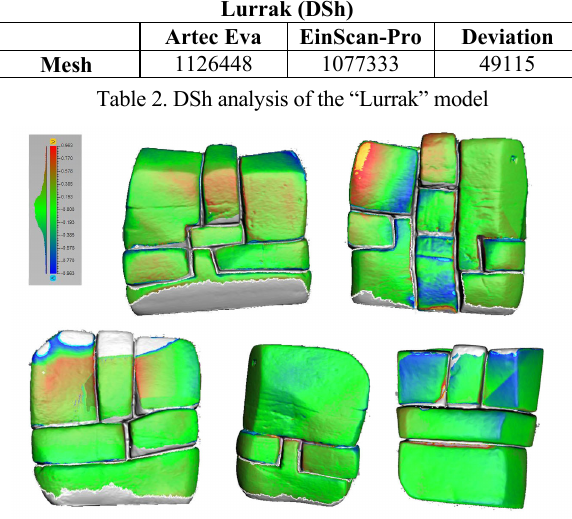
Figure 6. DF analysis of the “Ilarik II” model